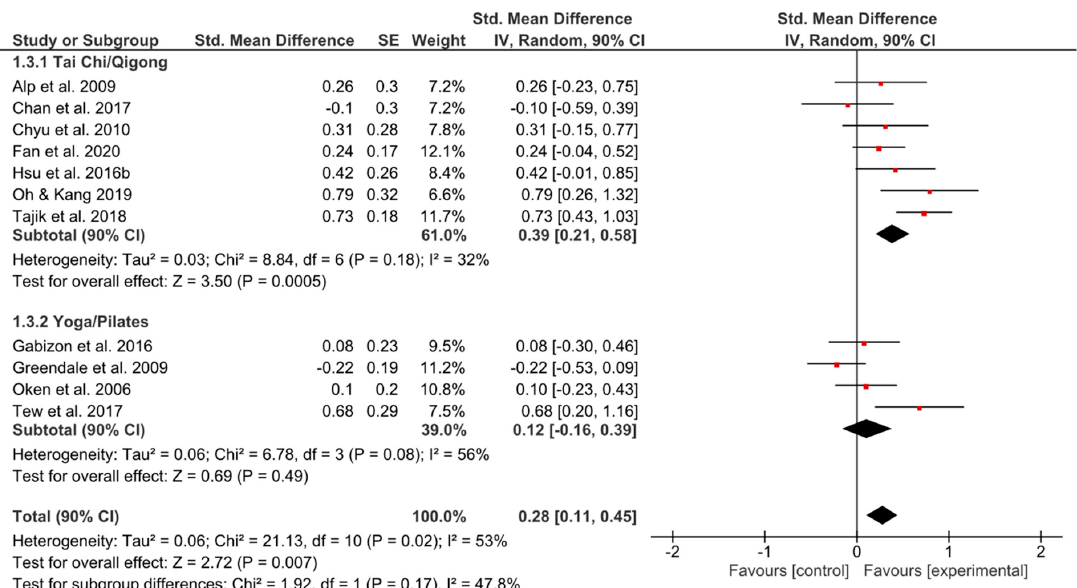
Figure 4. Standardized mean e ff ects of mind–body interventions on psychological functioning (subscale of quality of life) compared to a non-exercise control group. Data are separately presented for Tai Chi / Qigong and Yoga / Pilates. SE: standard error; IV: inverse variance model; CI: confidence interval; Std.: standardized.